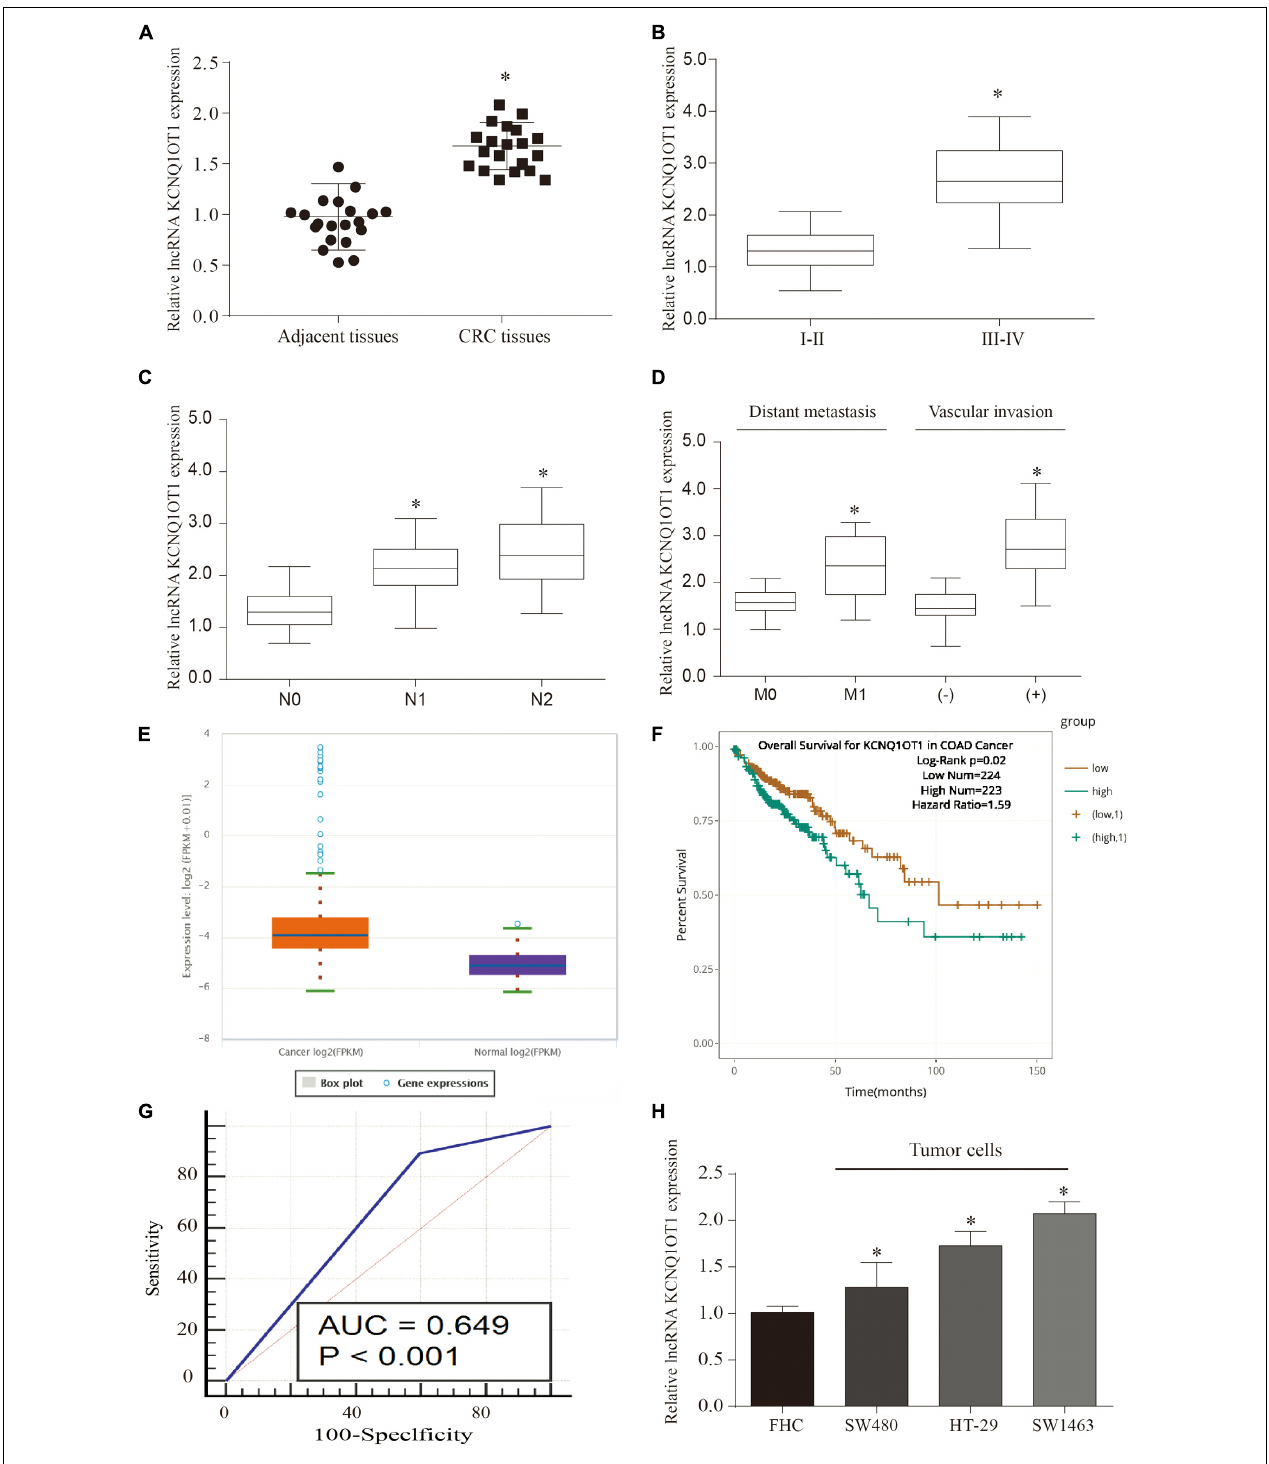
FIGURE 1 | Long non-coding RNA (LncRNA) KCNQ1OT1 was upregulated in colorectal cancer (CRC). (A) The expression of lncRNA KCNQ1OT1 in 20 pairs of patient samples. (B–D) The expression level of KCNQ1OT1 was positively correlated with tumor stage, lymph node metastasis, and vascular invasion. (E) The expression level of KCNQ1OT1 in The Cancer Genome Atlas (TCGA) database. (F) The 150-month prognosis analysis of KCNQ1OT1 in TCGA database. (G) The receiver operating characteristic (ROC) curve was used to analyze and verify the value of KCNQ1OT1 as a clinical diagnostic index. (H) The differential expression of KCNQ1OT1 in colon cells and colon cancer cells. ∗ p < 0.05 compared with the relative control group.